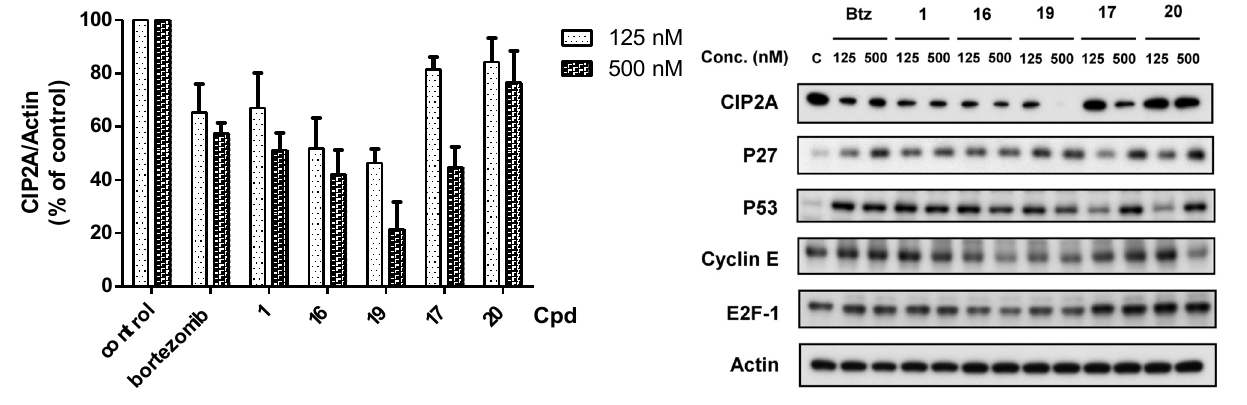
Figure 3. Effects of bortezomib and derivatives on protein levels of CIP2A in Sk-hep1 cells. Cells were exposed to bortezomib and derivatives at the indicated doses for 24 h. Cell lysates were assayed by Western blot. Immunoblots were scanned by a UVP BioSpectrum AC image system and quantitated using VisionWork LS software to determine the ratio of the level of CIP2A to actin. Columns , mean ( n = 3); bars ,